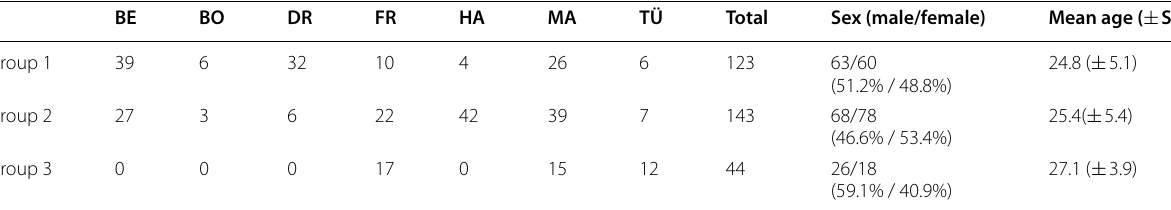
Table 2 Project A1: Subjects’ characteristics (sex, age)